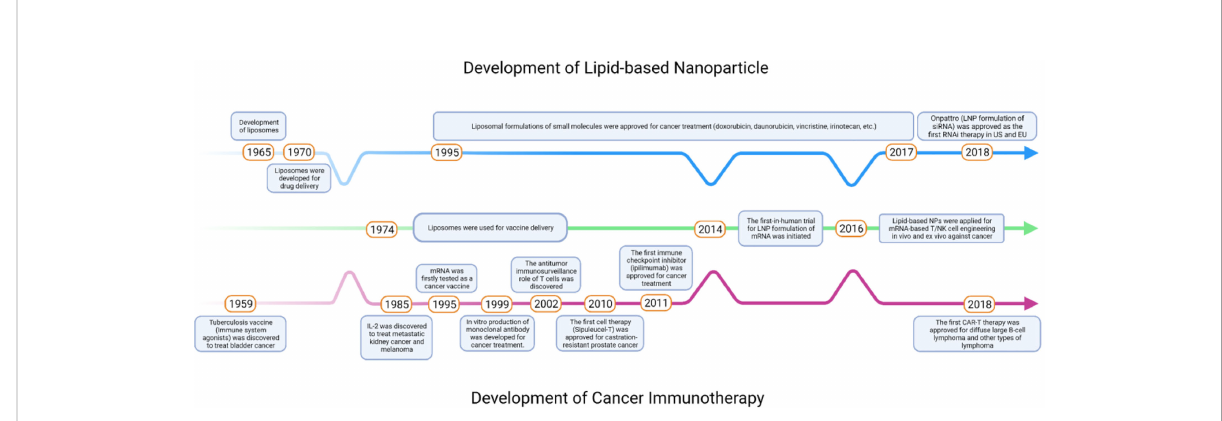
FIGURE 1 Timeline of key milestones throughout the development of lipid-based NPs and cancer